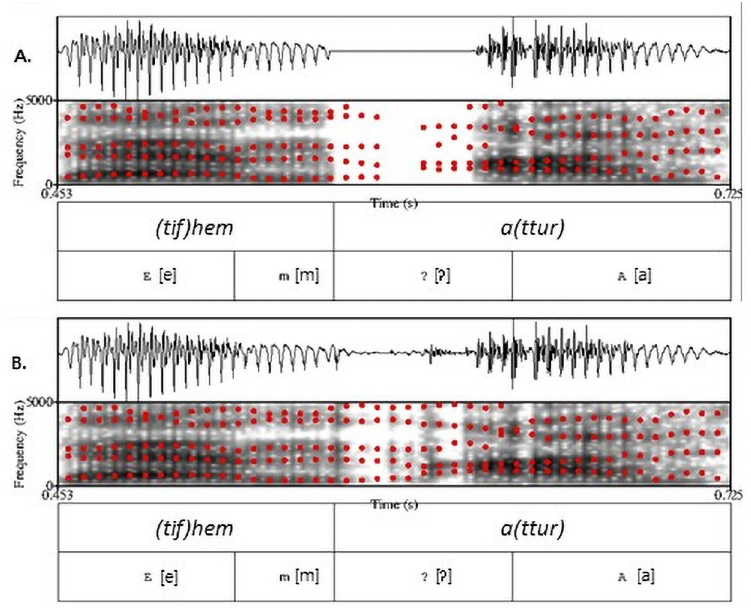
Fig 1. Oscillogram and spectrogram with estimated formant locations (5 formants assumed till 5kHz) at the critical juncture of one experimental item ( attur , Engl., ‘actor’) with glottal stop (A) and glottalization (B).